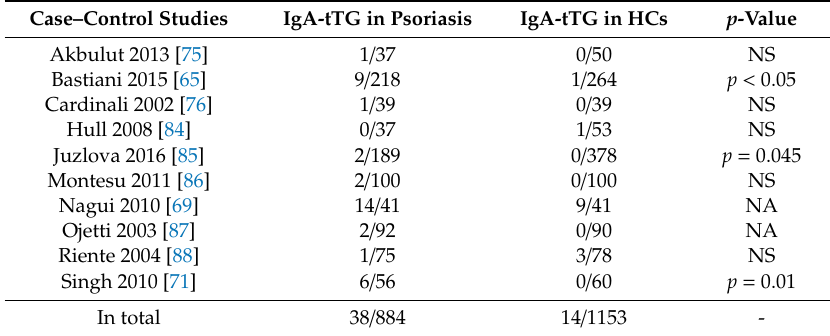
Table 2. Case–control studies estimating the prevalence of IgA-tTG in patients with psoriasis and HCs. Results are presented as “number of seropositive individuals” / “number of individuals tested”. HCs: healthy controls, IgA-tTG: class A immunoglobulins against tissue transglutaminase, NA: not available, NS: not